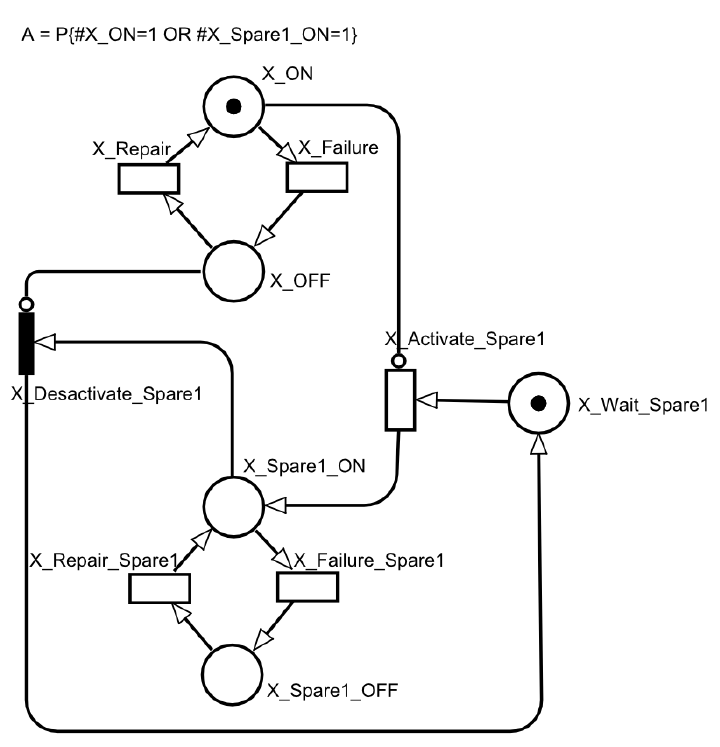
Figure 5. Cold standby model.